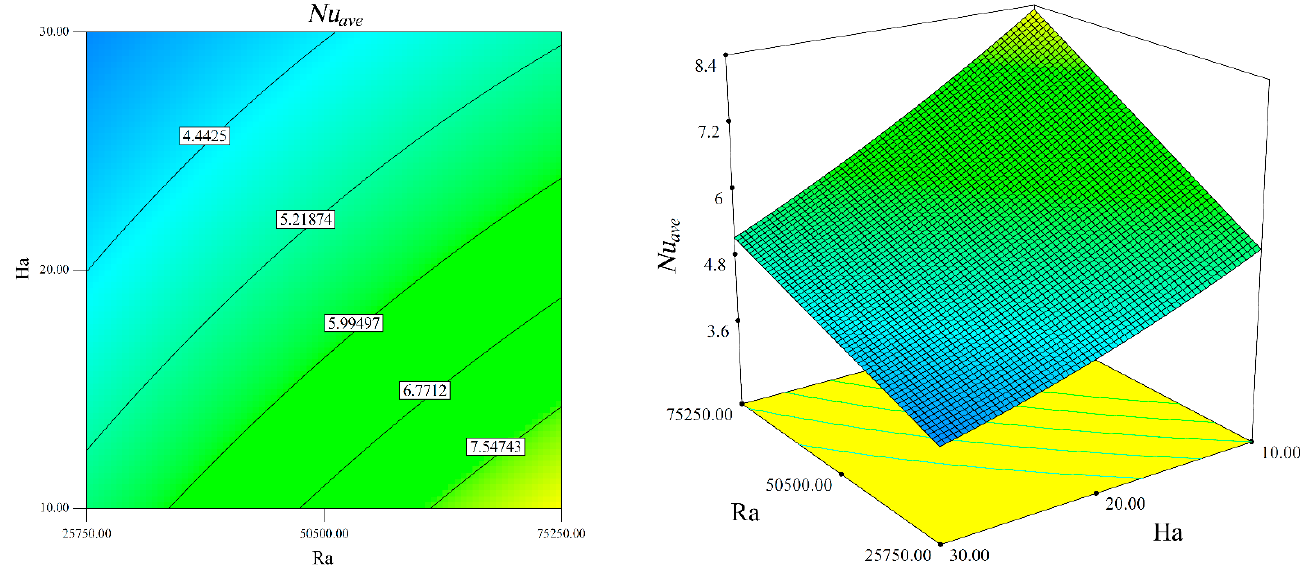
φ = 2%, and m = 3. Figure 6. Average Nu number for different values of Rayleigh and Hartmann numbers and shape factors when N = 2, φ = 2%, and m =